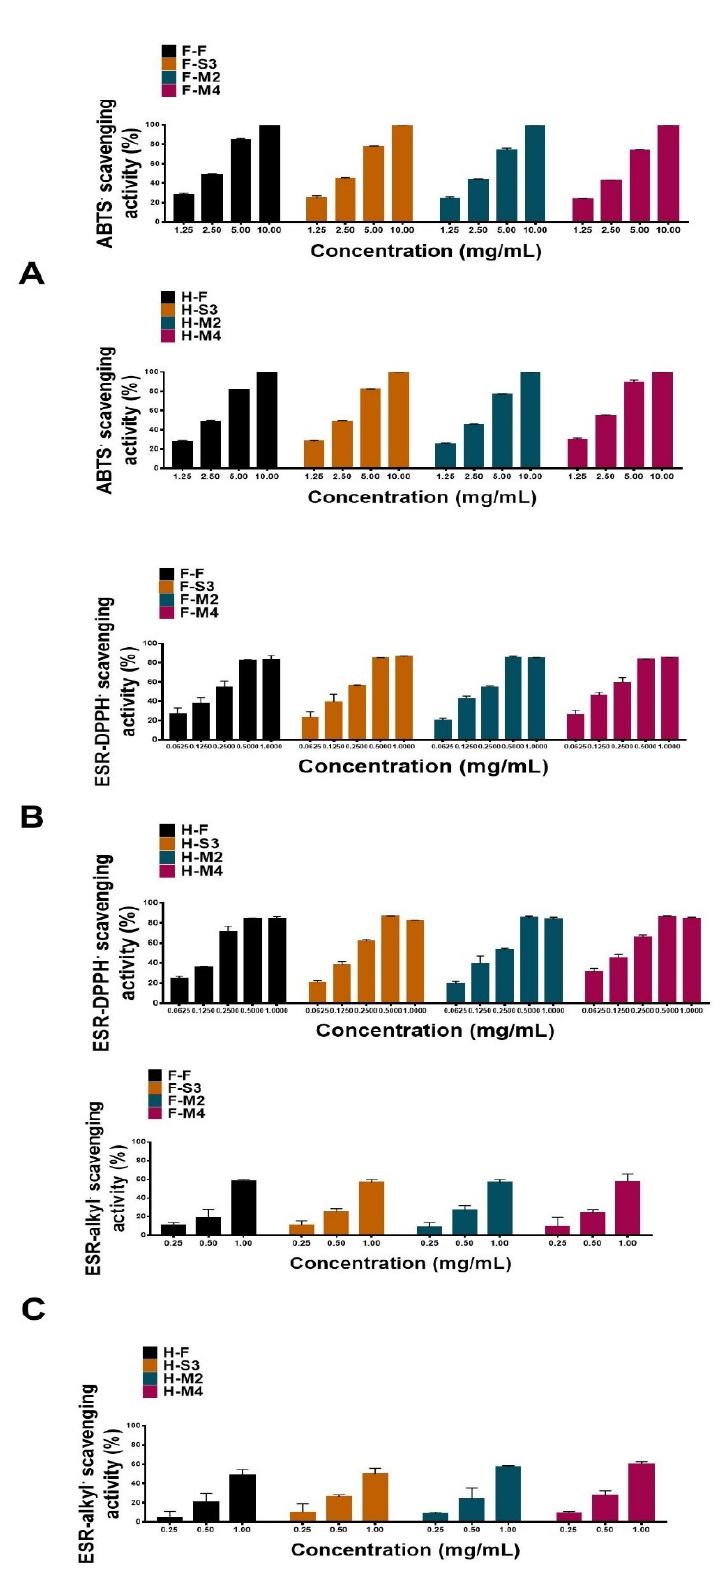
Figure 3. ABTS • ( A ), DPPH • ( B ), and alkyl • ( C ) free radical scavenging potentials of broccoli ex-